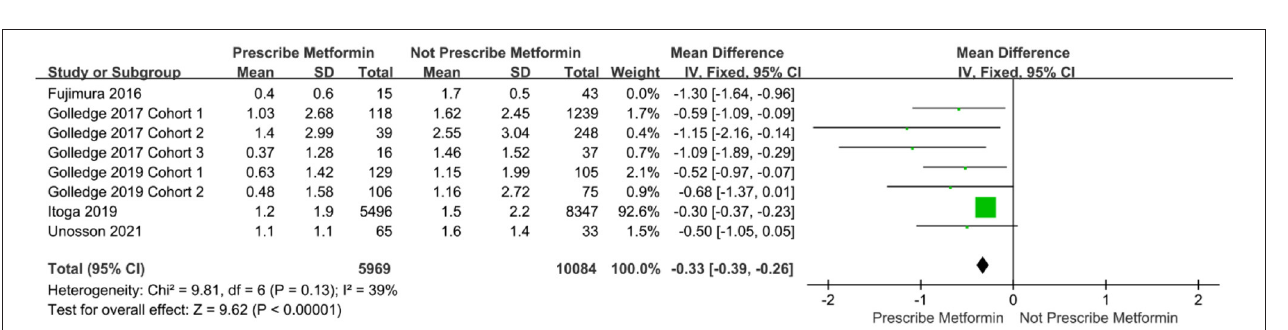
FIGURE 2 | Forest plot for the enlargement of abdominal aortic diameter.